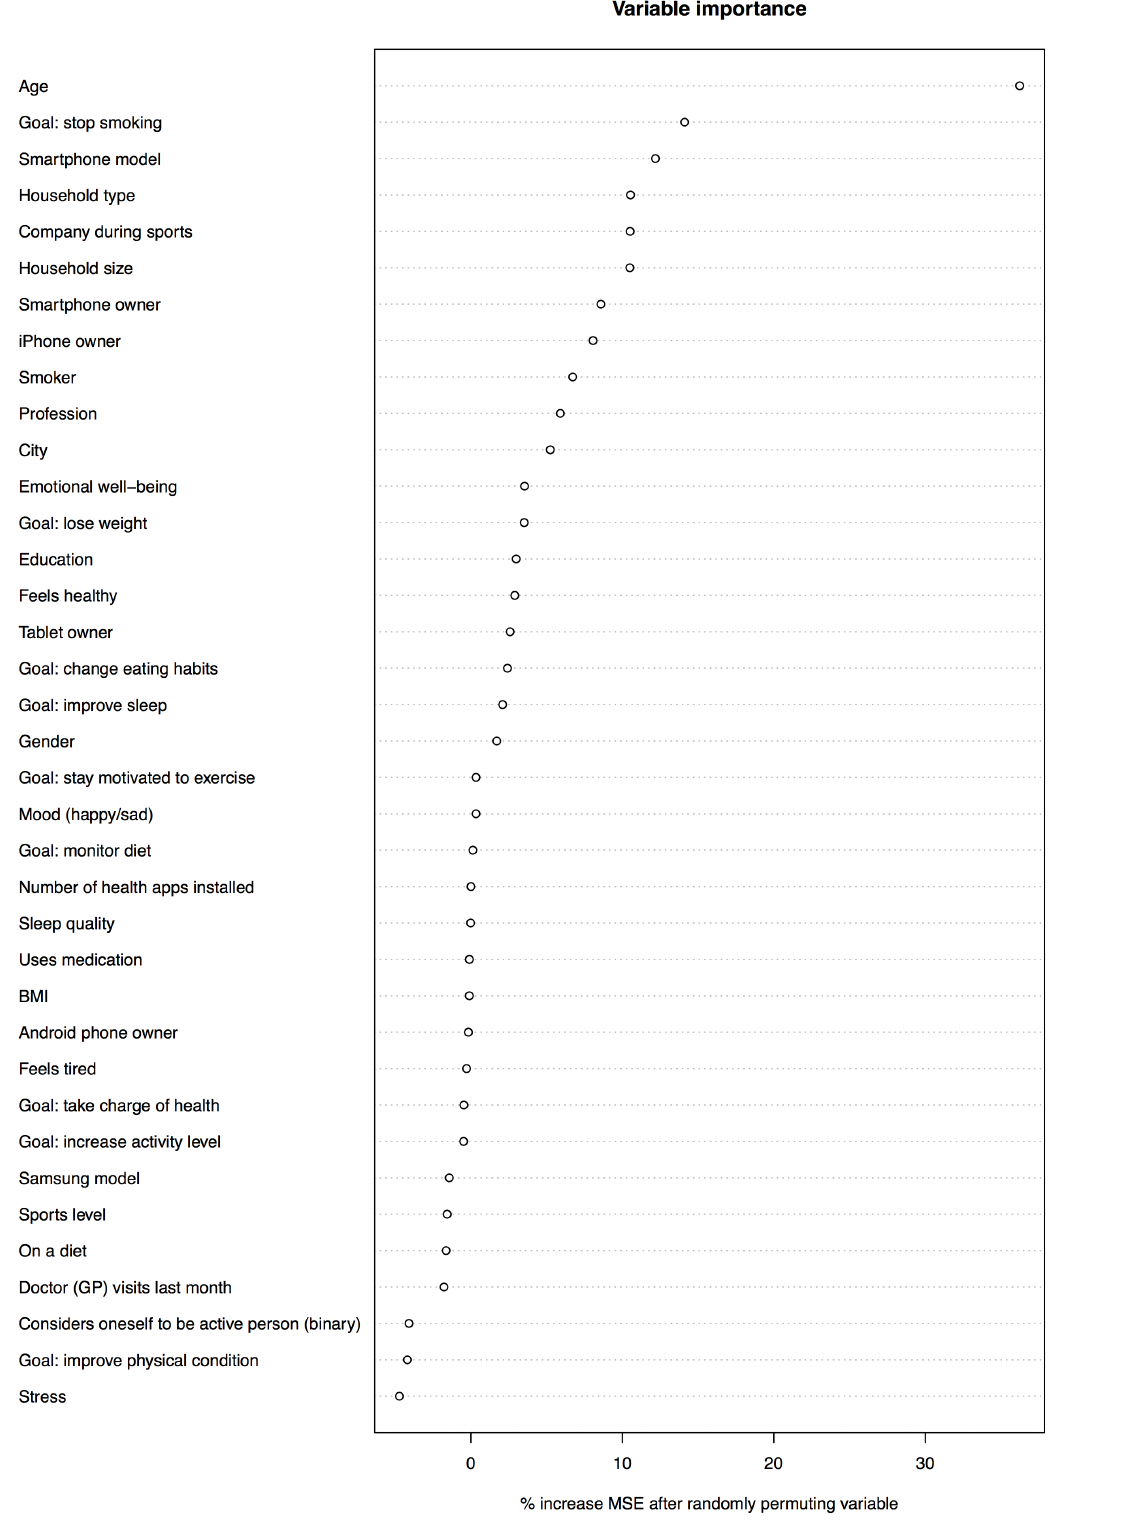
Figure 4. Plot of relative importance of predictors of sustained use in questionnaire 1 (Q1); BMI: body mass index, MSE: mean squared